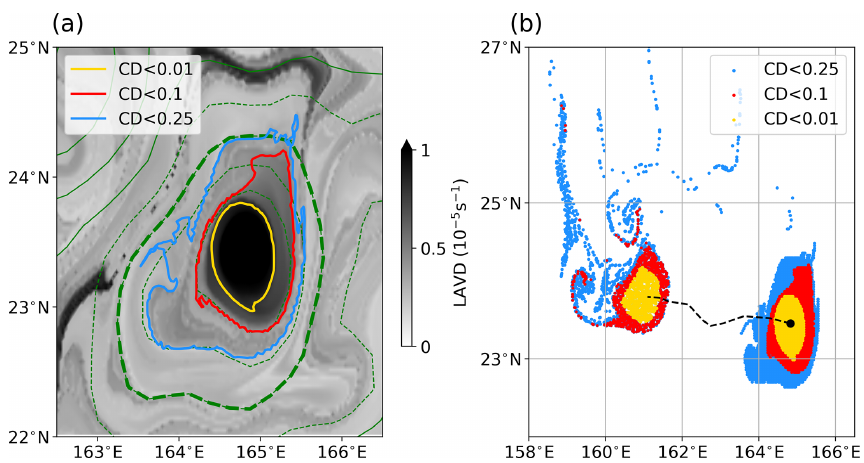
Figure 3. (a) A random example of the 30d LAVD field (color map) and three identified RCLV boundaries using three different CD values. The green dashed thick line is the eddy boundary defined by the SLA contour. (b) Initial and final particle positions trapped by three boundaries. The dashed black line is the eddy center trajectory, and the black dot is the initial eddy center.